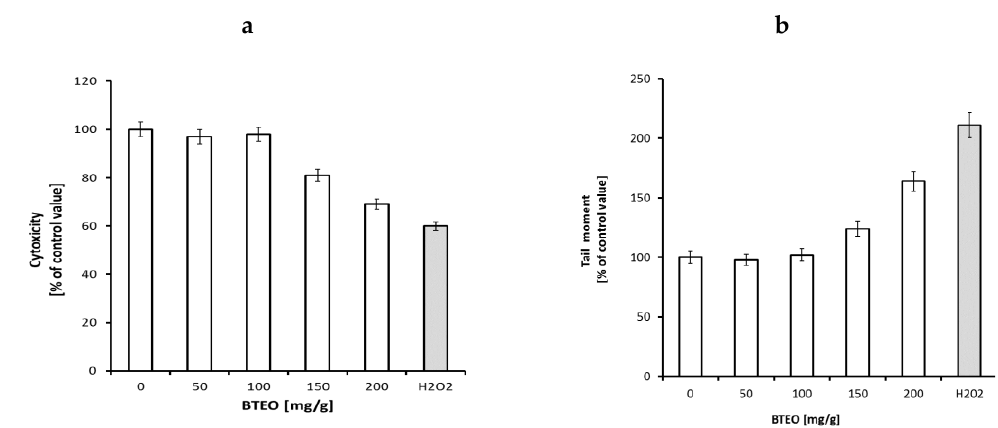
Figure 1. ( a ) Cytotoxicity of BTEO (50, 100, 150, 200 mg/g) in human dermal fibroblasts treated for 24 h. The MTT test is described in the Methods section. The mean of six independent experiments are presented; ( b ) COMET tail moments in human dermal fibroblasts treated with BTEO (50, 100, 150, 200 mg/g) for 24 h. The assay is described in the Methods section. H 2 O 2 was used as a positive